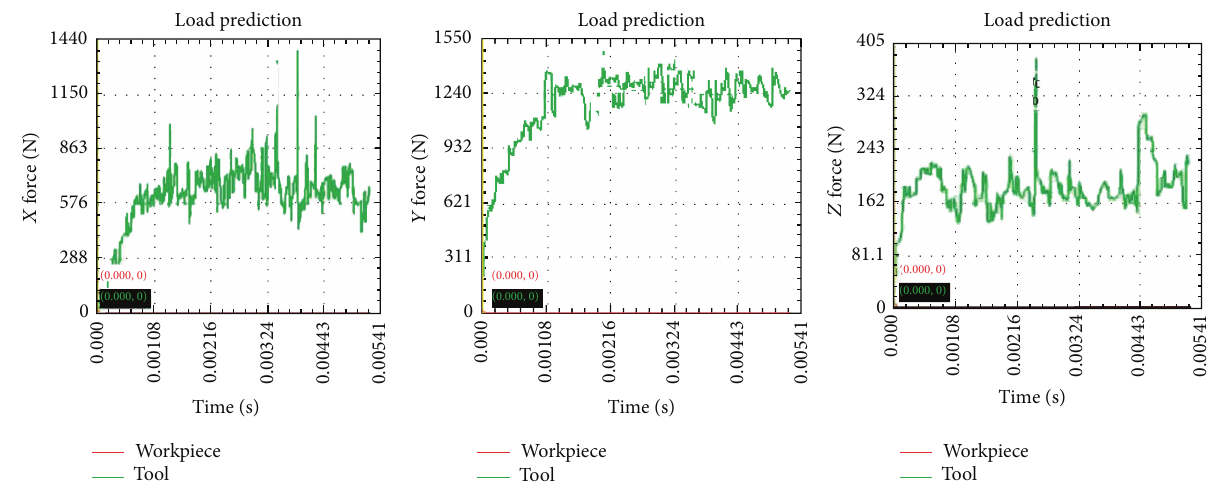
Figure 4: Simulation results of milling forces in 𝑥 , 𝑦 , and 𝑧 directions.